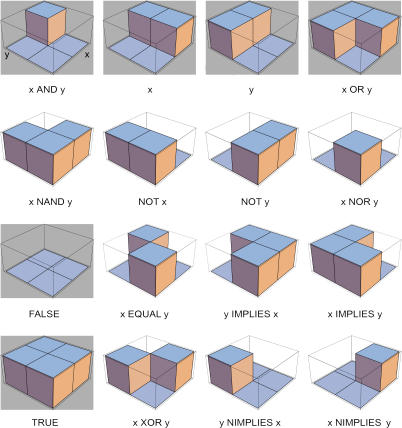
All 16 Possible Two-Input Boolean Logic GatesThe gates are functions of two inputs,
x and
y, each of which can be 0 or 1. The top left gate, for example, is an AND gate whose output is 1 only when both
x = 1 and
y = 1, and zero otherwise. The AND gate is represented by a high plateau when
x = 1 and
y = 1, and by three low plateaus for the other combinations of
x and
y. The six gates with a shaded background are realizable by the model of the
lac input function, whereas the ten gates with a white background are not (forbidden gates).